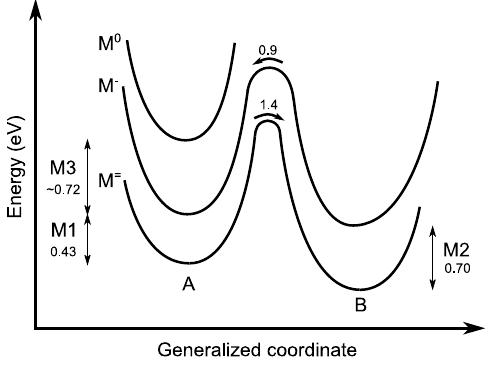
Figure 9. Coordinate configuration diagram for the M-center constructed based on M1, M2, and M3 activation energies determined from DLTS measurements on neutron irradiated (10 13 cm − 2 ) SBD and activation energies for transitions between A and B configurations of M-center taken from [34]. All energy values are in the eV unit.